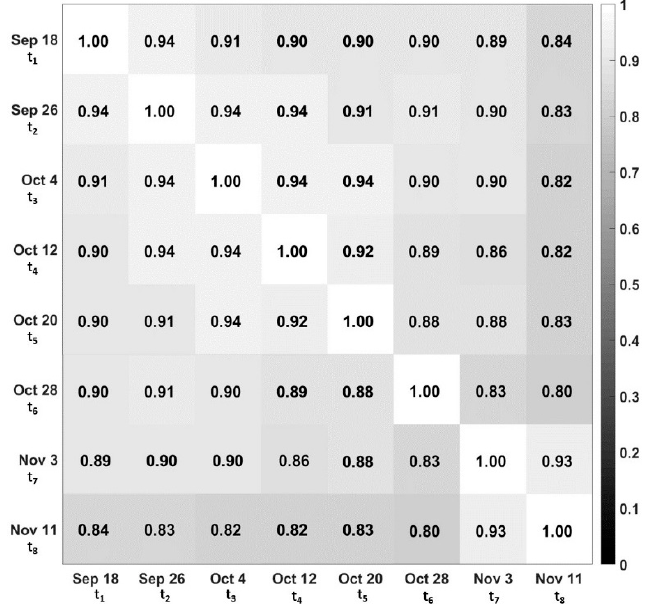
Figure 7. Multi-temporal linear Pearson correlation matrix for all datacubes. Grayscale indicates the correlation level.